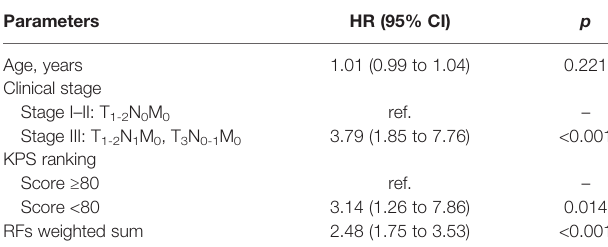
TABLE 4 | Final model by training set.